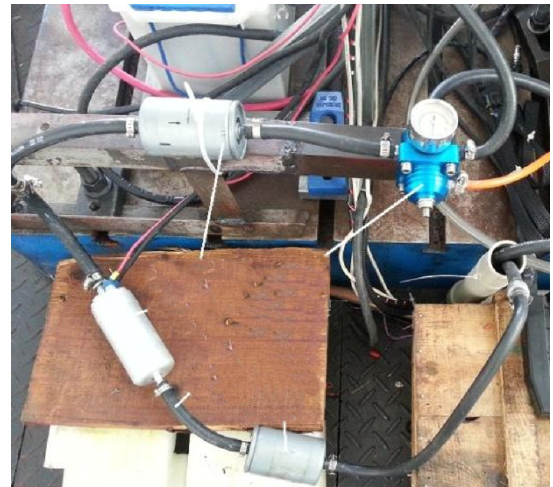
Figure 8. Fuel tank and recorder.